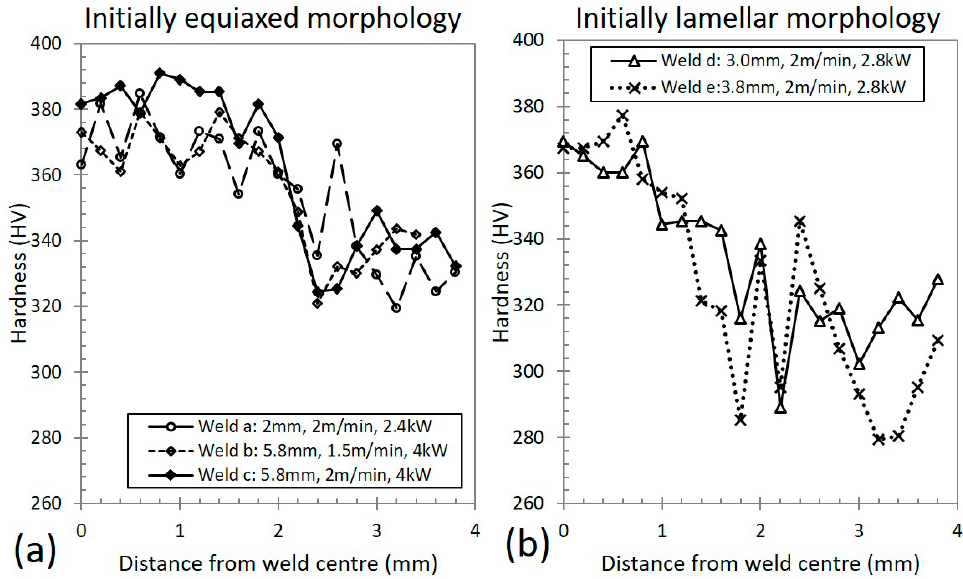
Figure 4. Hardness profiles perpendicular to the weld pass for the plates with an ( a ) initially equiaxed grain morphology and ( b ) initially lamellar grain morphology .